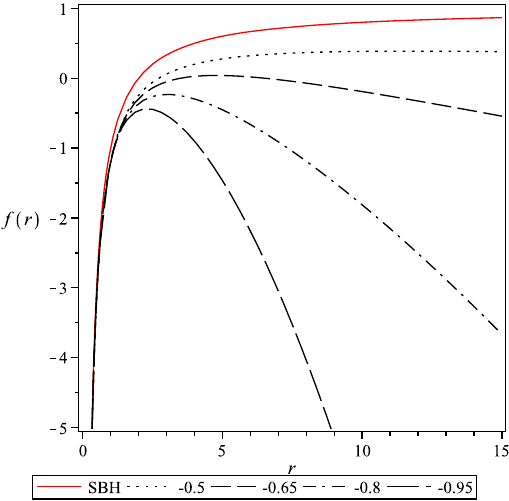
mentioned in the diagram. Right figure: a = 0 . 1, q = 0 . 1 and different values of w q as mentioned in the diagram solid line curve represents the function for SBH